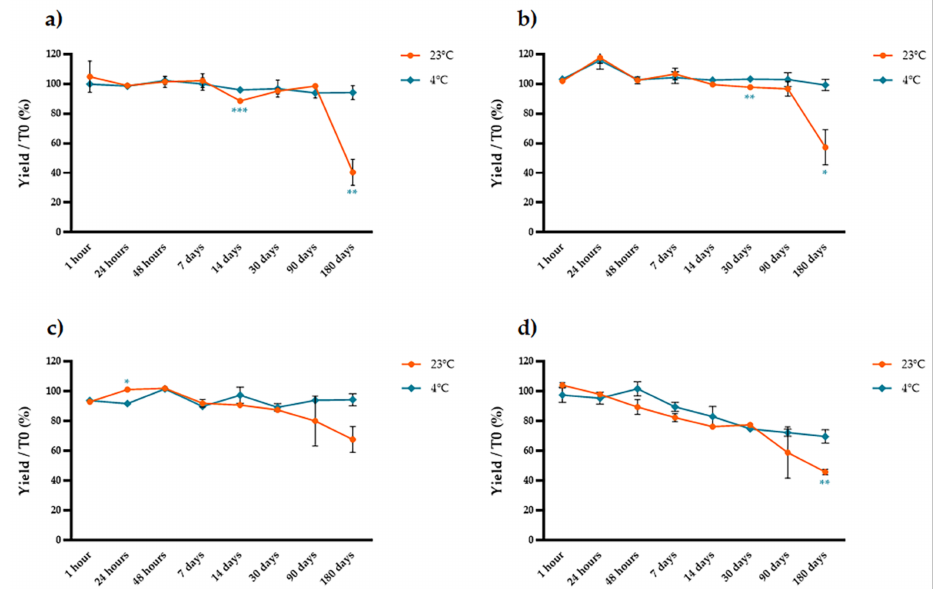
Figure 7. Stability over time of three-fold concentrated extracts prepared with different solvents and stored at 23 ◦ C (blue line) or 4 ◦ C (red line). The samples were extracted with ( a ) water, ( b ) 12.5% ethanol, ( c ) 25% ethanol, and ( d ) 50% ethanol before concentration. The y axis shows the yield as a percentage relative to the samples that were analyzed immediately after extraction. Significant differences between the two storage temperatures are indicated with asterisks (* p < 0.05, ** p < 0.01, *** p < 0.001, **** p < 0.0001). Data are means ± SD ( n = 3 independent experiments; multiple t -tests with Holm–Šid á k correction, p < 0.05).